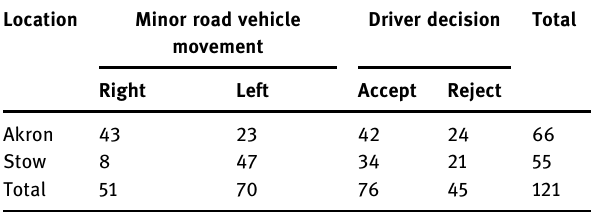
Table 2: Data point collected on the fi